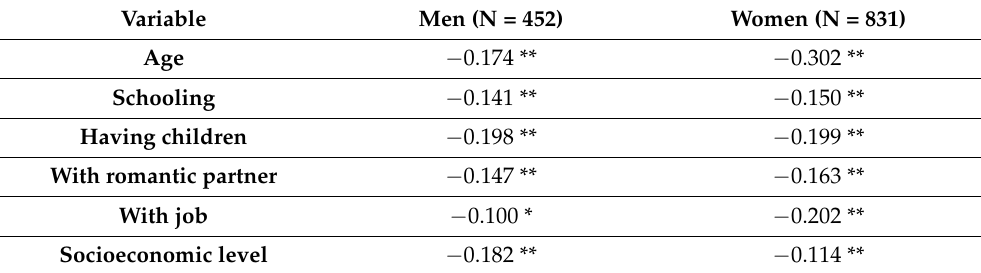
Table 4. Bivariate correlations between sociodemographic variables and stress.